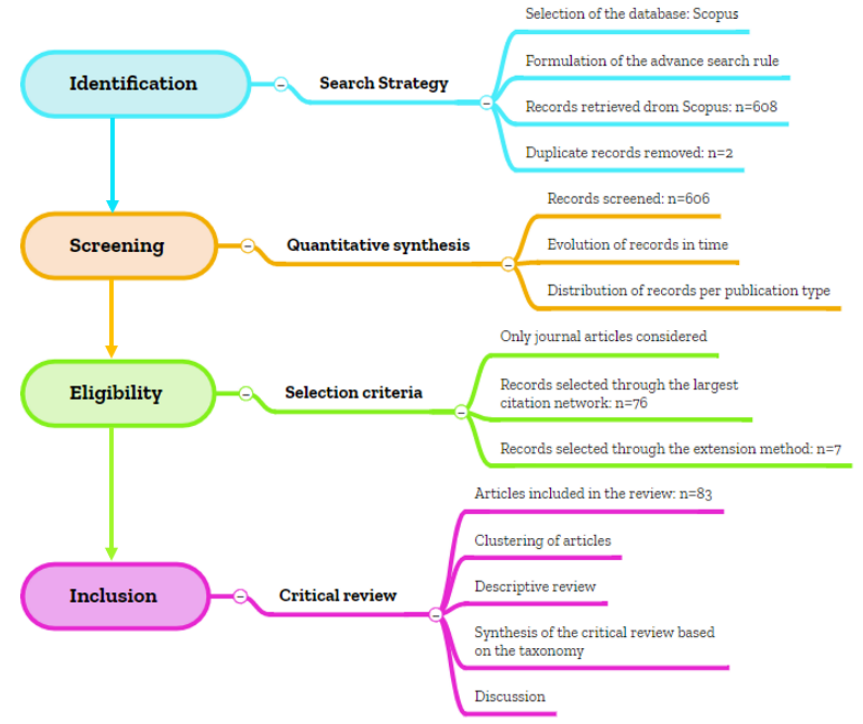
Figure 1. Stages of the systematic literature review.